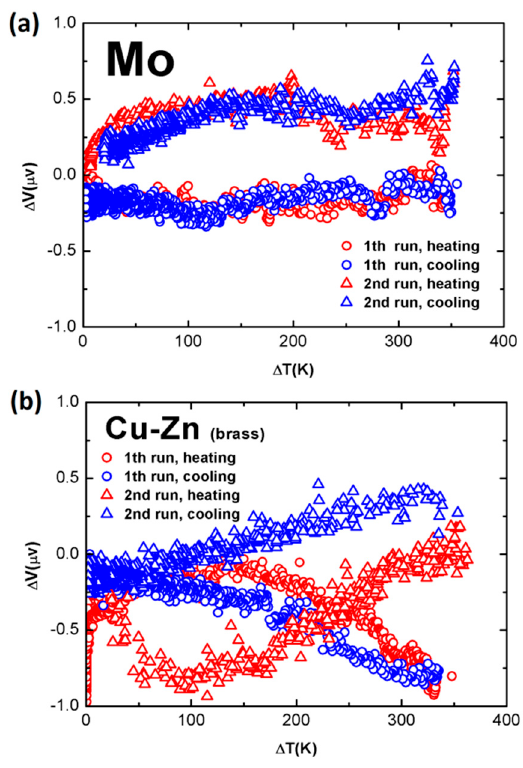
Figure 6. Calibration results of “identical wire” samples made from ( a ) one piece of 0.5 mm diameter Mo wire and ( b ) one piece of 1.0 mm diameter brass wire.